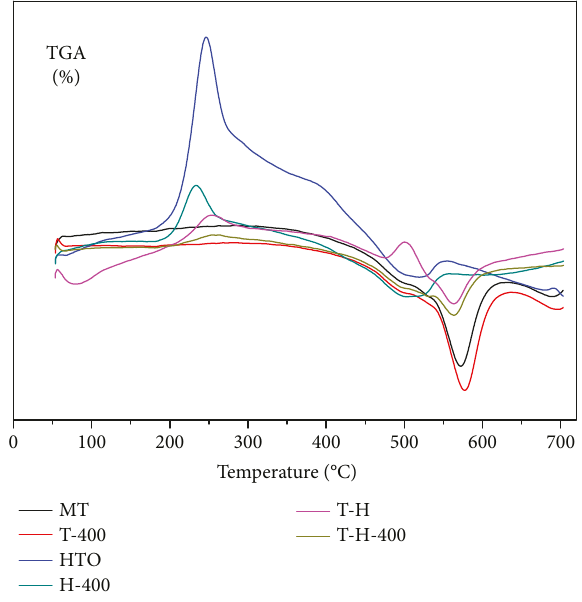
Figure 2: TG curves of all